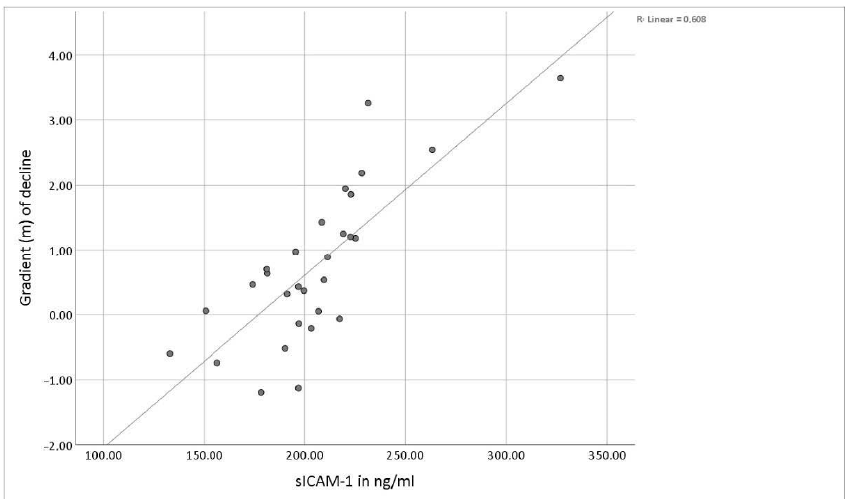
Figure 6. Illustration of the gradient of the decline in the sICAM-1 concentration after passing through the experimental setup in relation to the initial sICAM-1 concentration. The values of all test participants are shown.